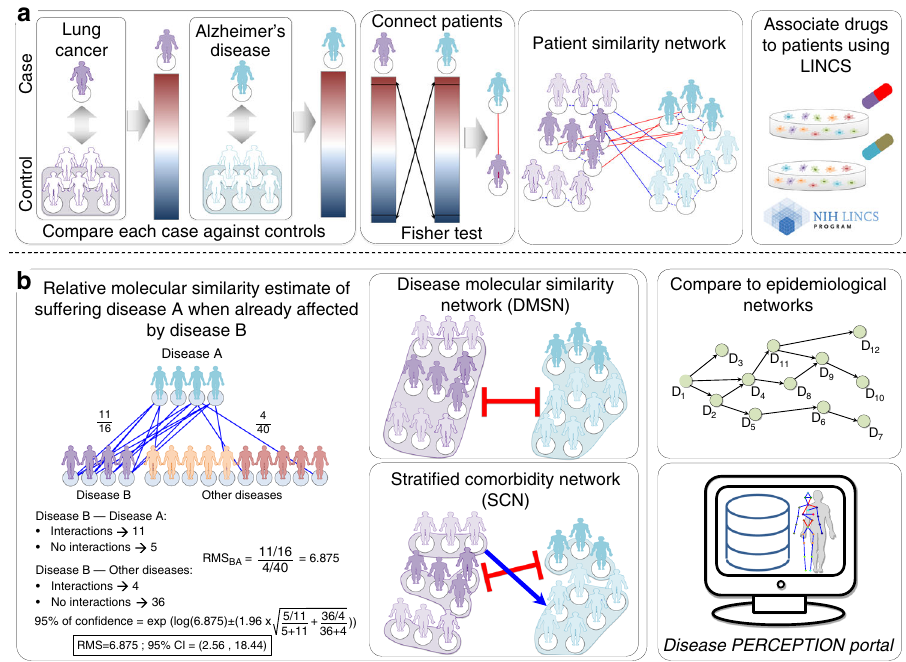
Fig. 2 Summary of the steps followed for the comorbidity analyses conducted using transcriptomic data. a Generate differential gene expression pro fi les for each patient (comparing their expression with the expression detected in the control samples), selecting the top 500 up- and downregulated genes for the Fisher ’ s exact test analysis. Then, use the similarity of these pro fi les to generate the patient similarity network. Drugs are then associated to patients based on the similarities between patients ’ differential expression pro fi les and the alterations of gene expression generated by a large collection of drugs on cell lines as recorded in the LINCS database (see “ Methods ” ). b The number of observed patient − patient interactions connecting different diseases is used to calculate relative molecular similarities as shown, leading to the construction of the Disease Molecular Similarity Network (DMSN) and of the Strati fi ed Comorbidity Networks (SCN). The obtained DMSN is compared to published epidemiological networks and all results are available in the Disease PERCEPTION